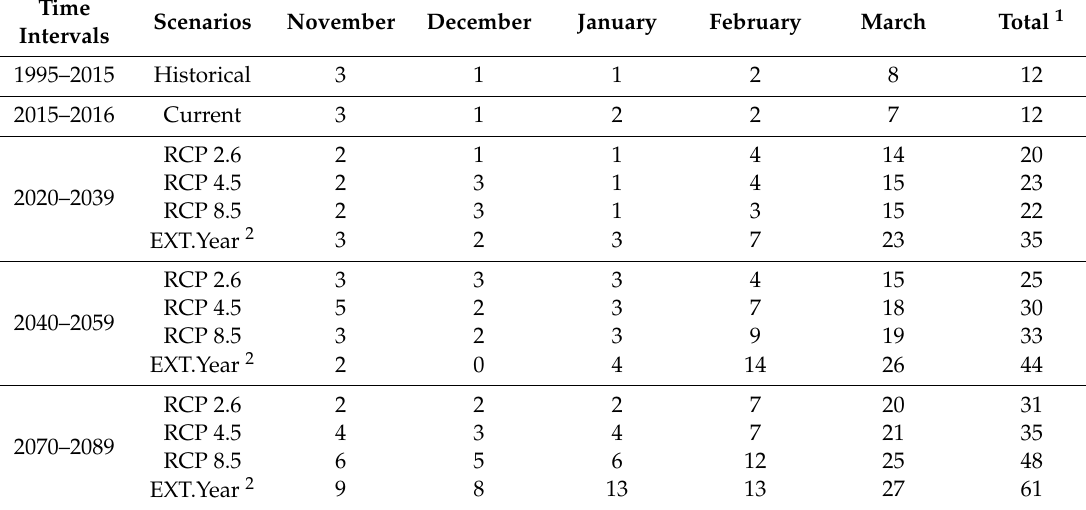
Table 1. Average projected shut-down days from the HadGEM2-ES model with five time intervals and three radiative forcing values for future projections by month, with Sundays and holidays